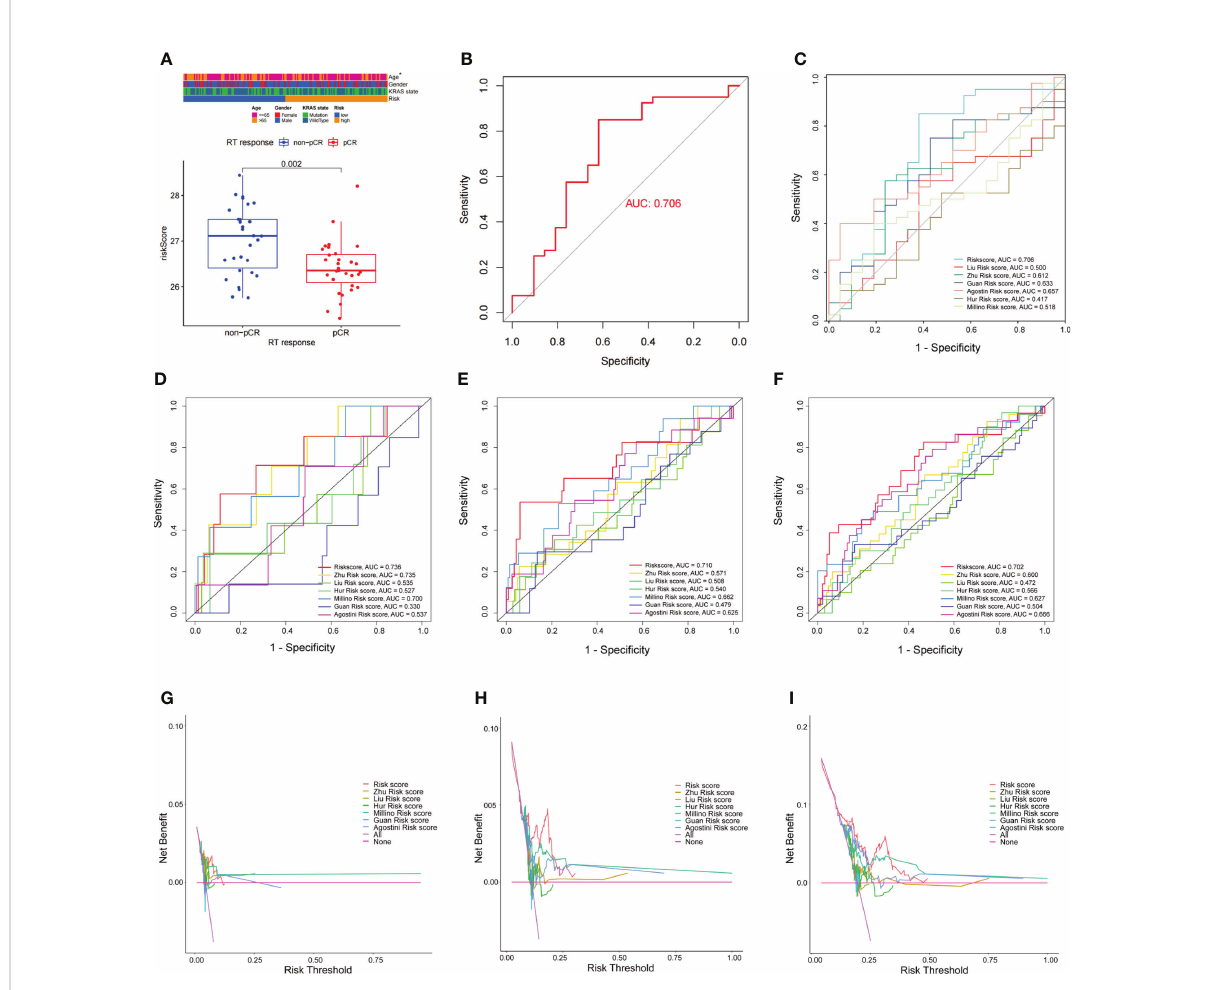
FIGURE 5 Comparison of FAM-related signature and previously published multi-gene models. (A) FAM-related risk score association with nCRT response. (B) ROC curves used to evaluate the ability of predicting nCRT response using FAM-related signature. (C) The ability of the FAM-score model to predict nCRT response of patients with rectal cancer treated with nCRT is better than previously published multi-gene models. (D – F) AUC values at 1-, 2-, and 3-years DFS of FAM-score model and previously published multi-gene models. (G – I) The DCA for FAM-score model compared with previously published multi-gene models. nCRT, neoadjuvant chemoradiotherapy; FAM, fatty acid metabolism; AUC, area under the curve; DCA, decision curve